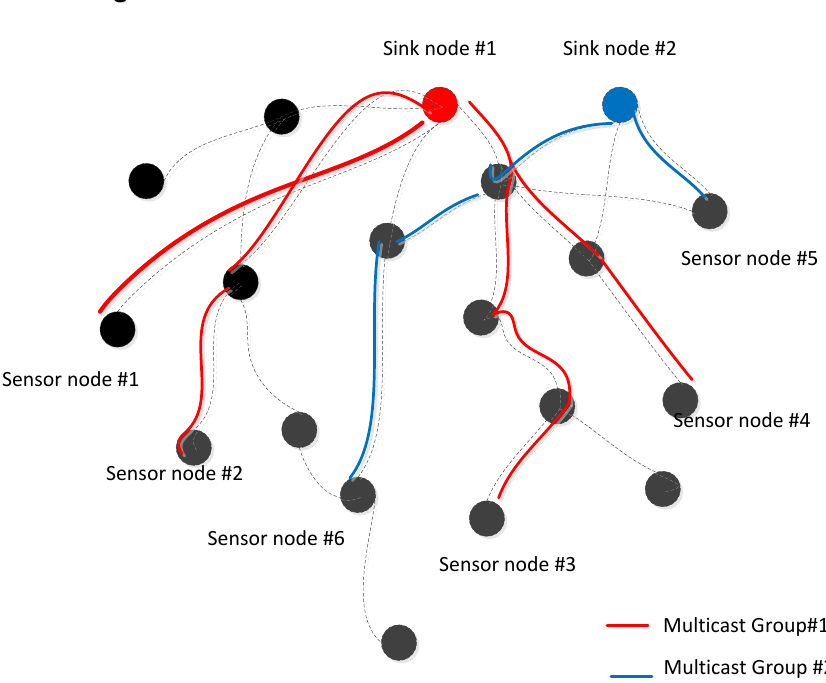
Figure 4. Multi-rate multicast wireless sensor network.